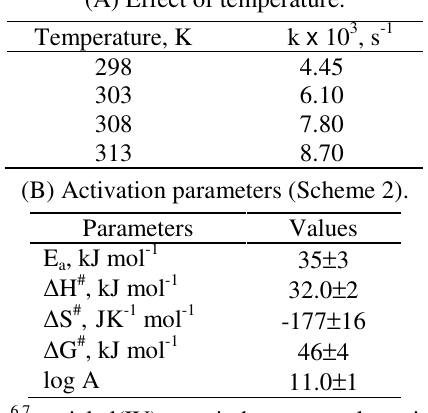
Table 2. Thermodynamic activation parameters for the oxidation of 4-hydroxycoumarin by DPN in aqueous alkaline medium with respect to the slow step of scheme